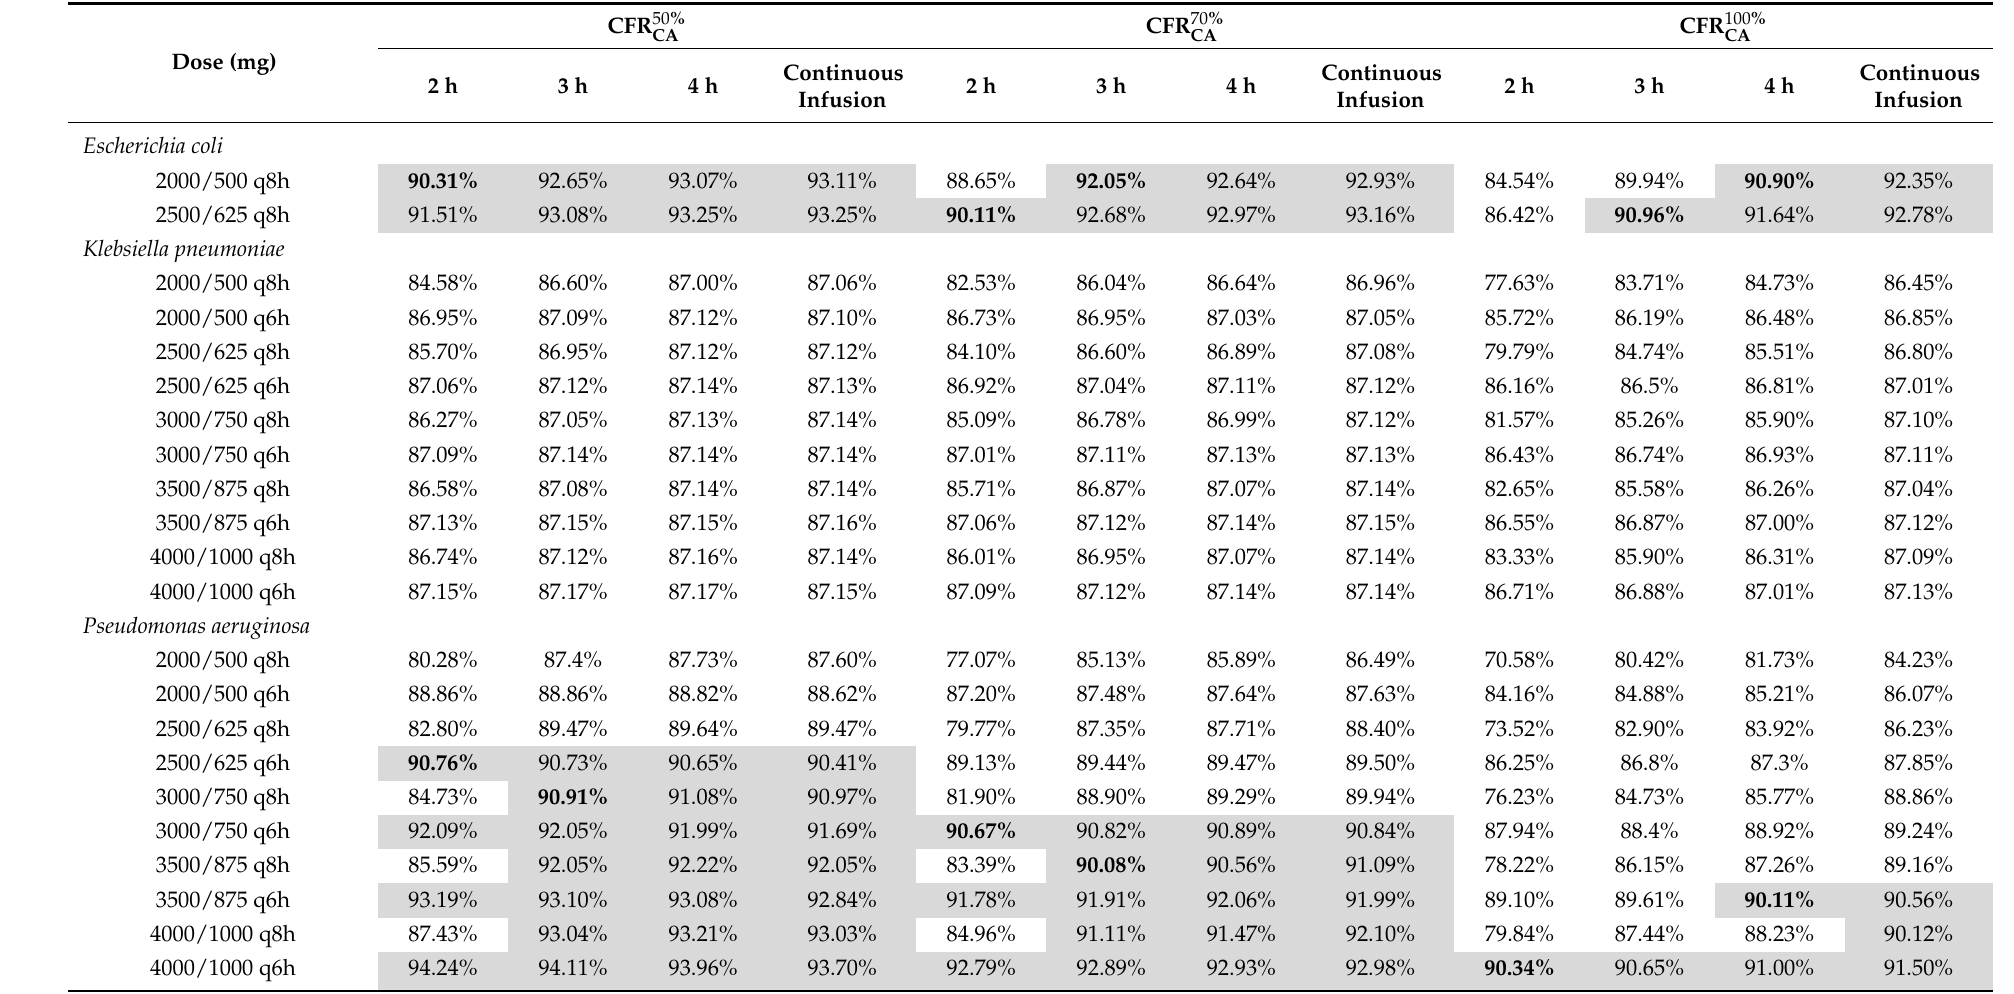
Table 1. Cumulative fraction of responses for ceftazidime/avibactam for Enterobacteriaceae and Pseudomonas aeruginosa